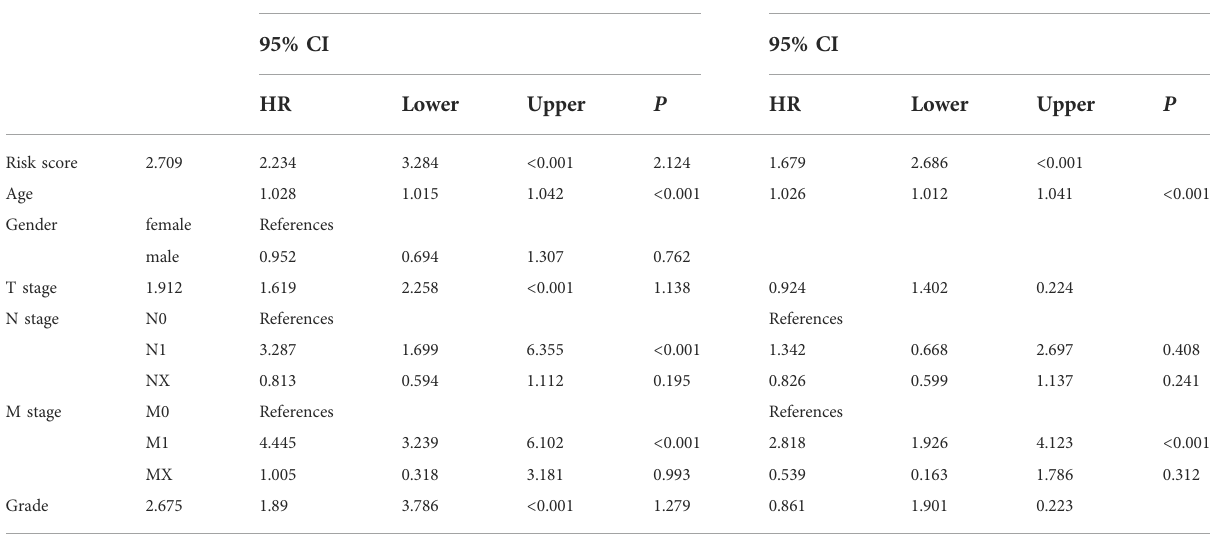
TABLE 2 Cox regression analyses in TCGA